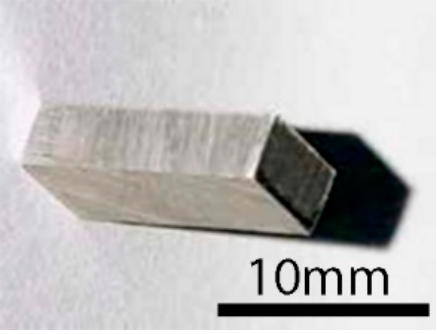
Figure 2. Mg-1Ca sample view.